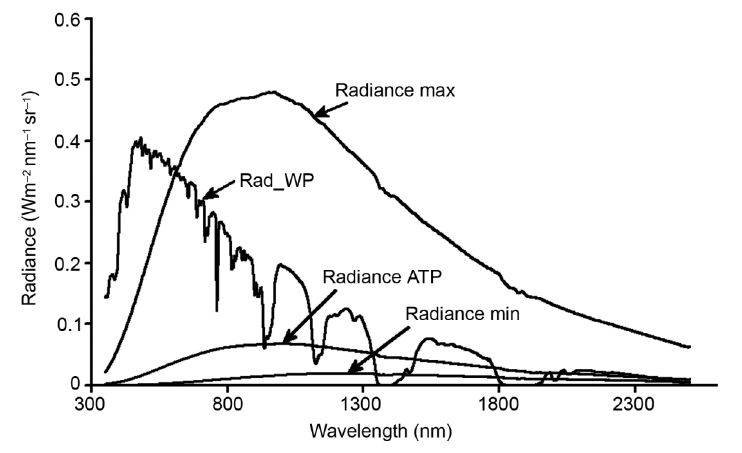
Fig. 2. Radiances inherent to the radiometric calibration process: Rad_WP: radiance of Spectralon panel meas- ured in open air at our latitude in summer time; Rad_max (maximum radiance) and Rad_min (lowest radiance) measured in TB in the new procedure; Rad_ATP: radiance in the TB during